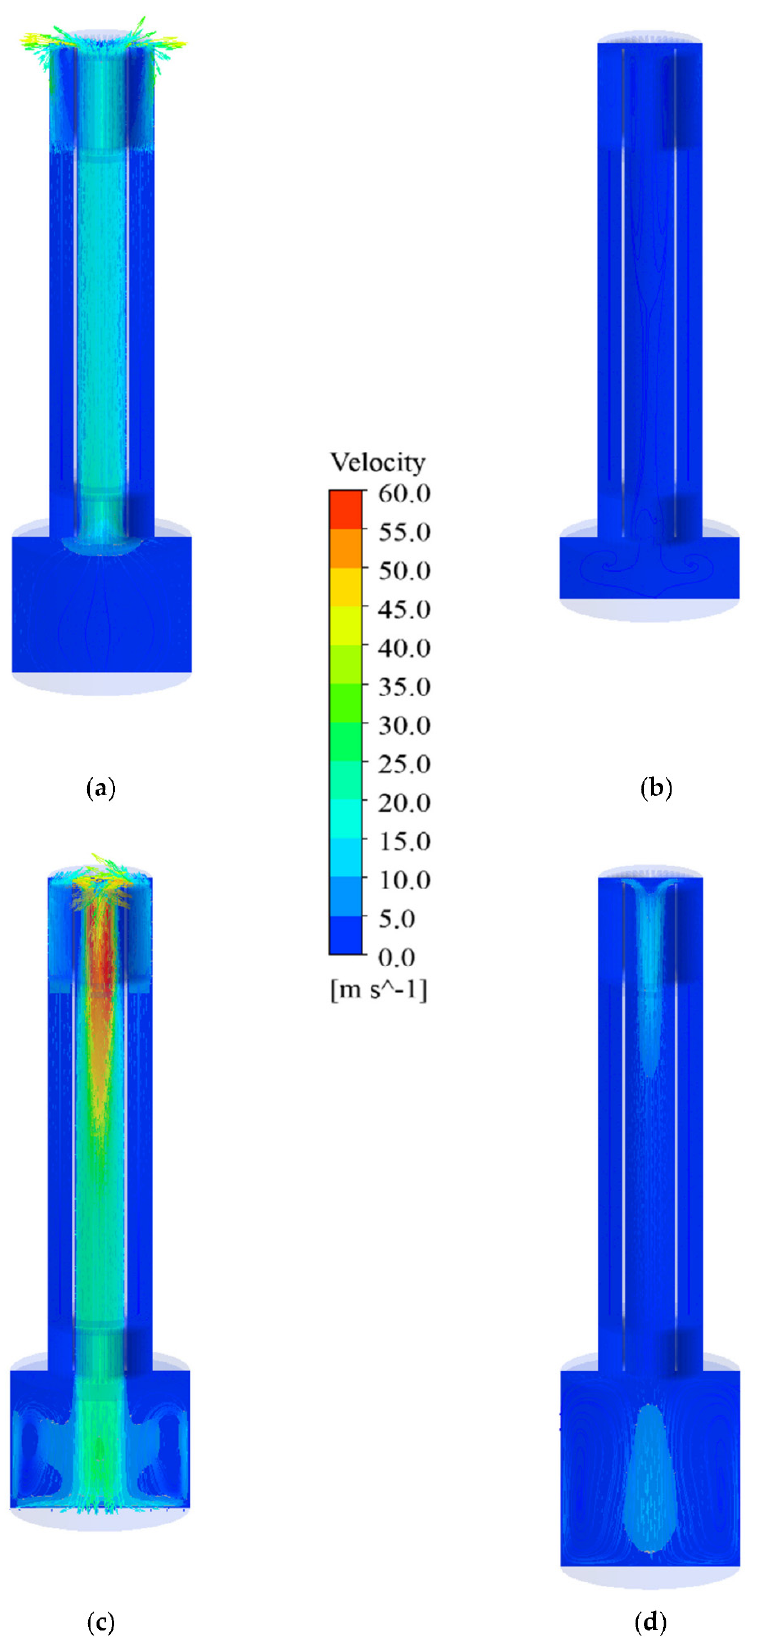
Figure 7. Velocity contour and vector fields: ( a ) 0 degrees; ( b ) 90 degrees; ( c ) 180 degrees; ( d ) 270 degrees.